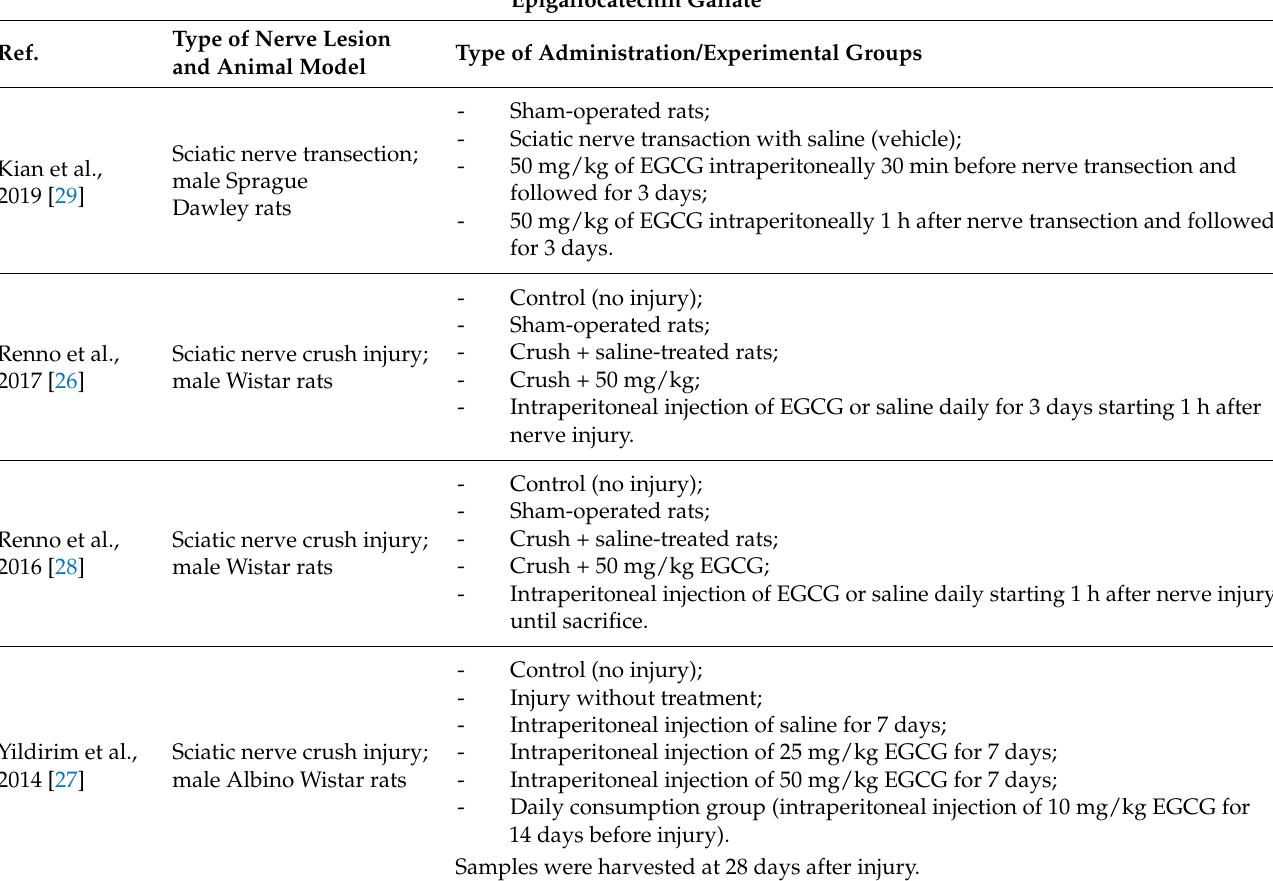
Table 1. Flavanols: Table showing the experimental method (type of nerve injury and animal model), the dose, and method of administration of epigallocatechin gallate (EGCG) and green tea extract (GTP). Included references are listed ascending in accordance to their publication